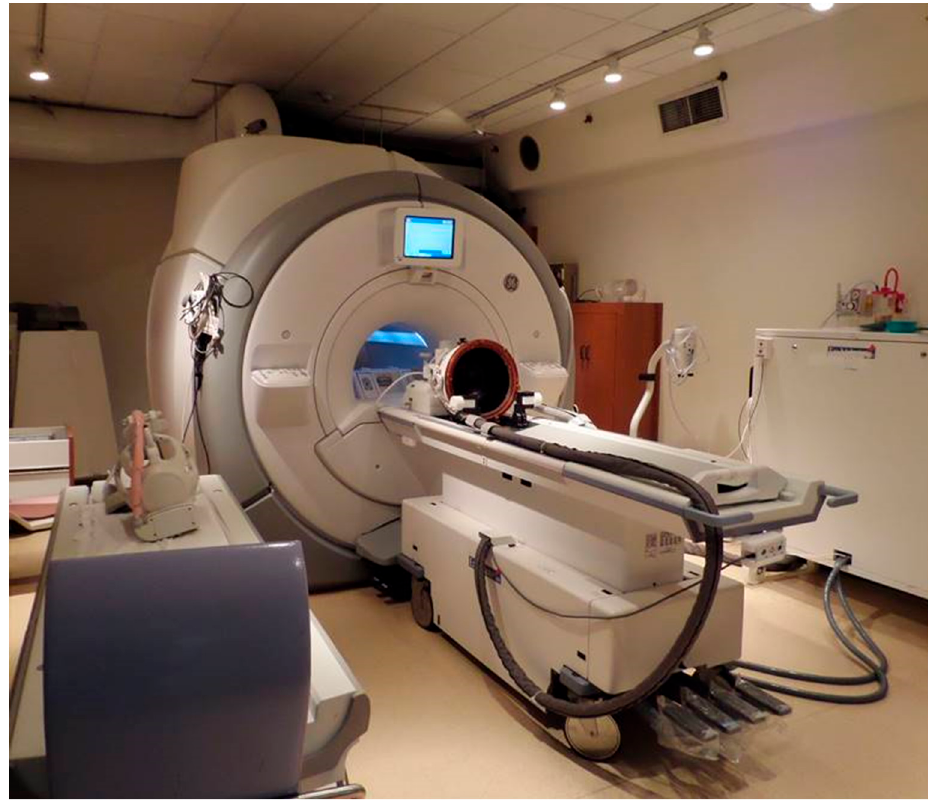
Figure 5. An ExAblate Neuro (InSightec, Haifa, Israel) MRgFUS transducer helmet on an MRI table (located at Sunnybrook hospital, Toronto, Canada).